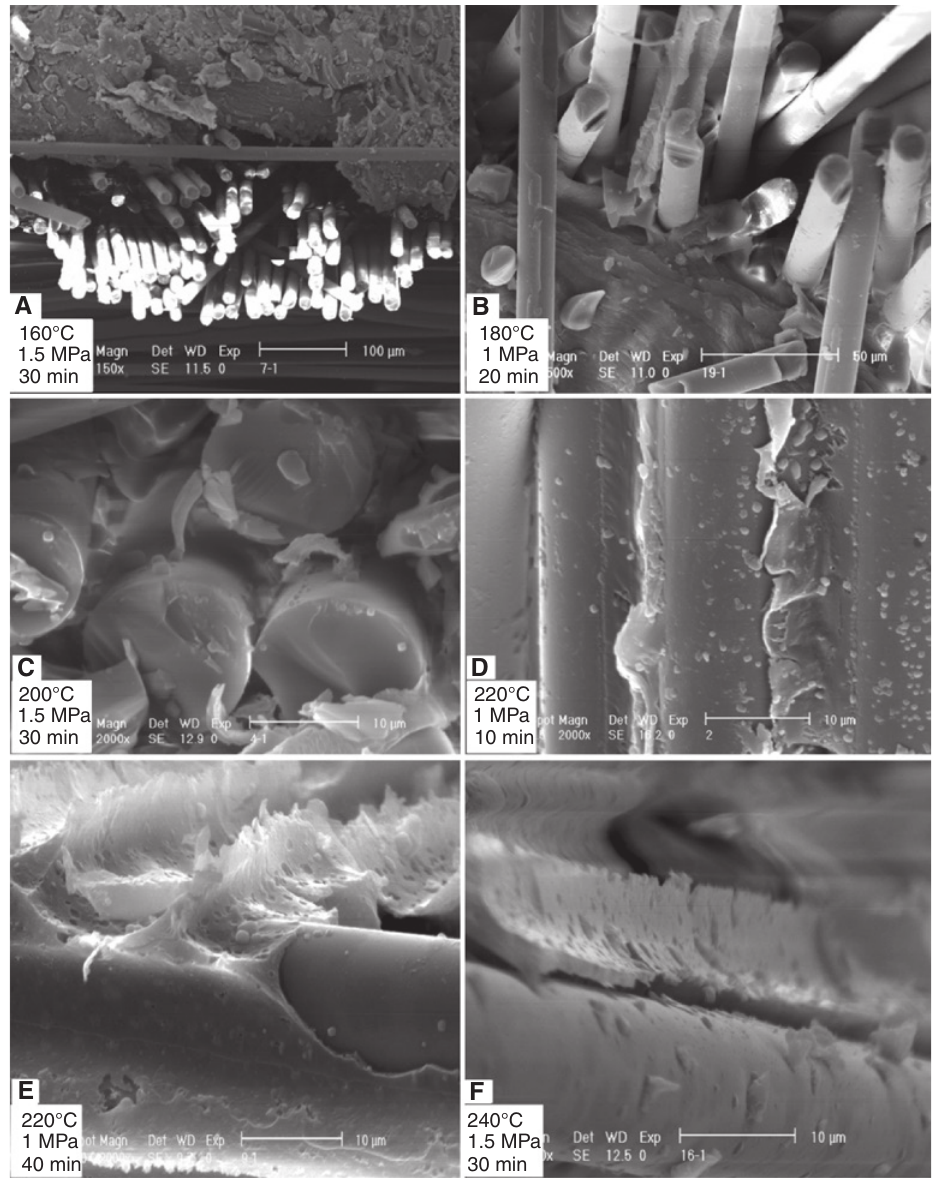
Figure 11: SEM images of fiber/matrix impregnation of the composite laminates produced at different conditions.